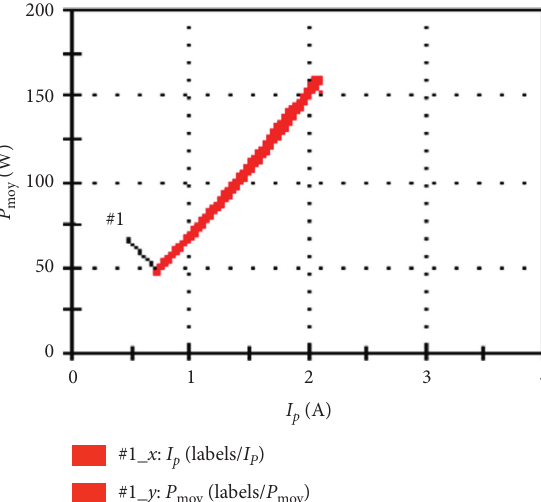
Figure 29: Evolution of photovoltaic power.